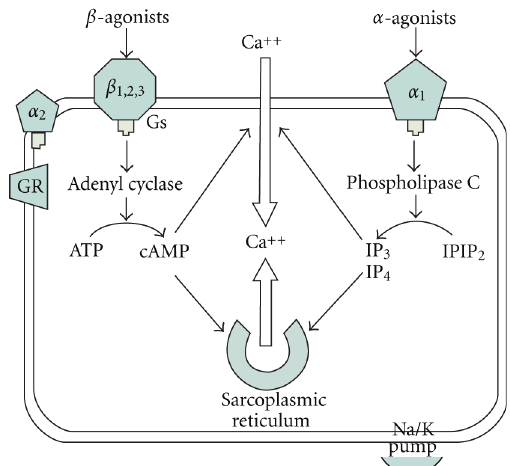
Figure 1: Schematic representation of the action of epinephrine on intracellular calcium in myocytes. ATP: adenosine triphosphate, cAMP: cyclic adenosine monophosphate, Gs: G protein com- plex, IP: inositol phosphate, PIP 2 : phosphoinositol diphosphate, (adapted from OH’S intensive care